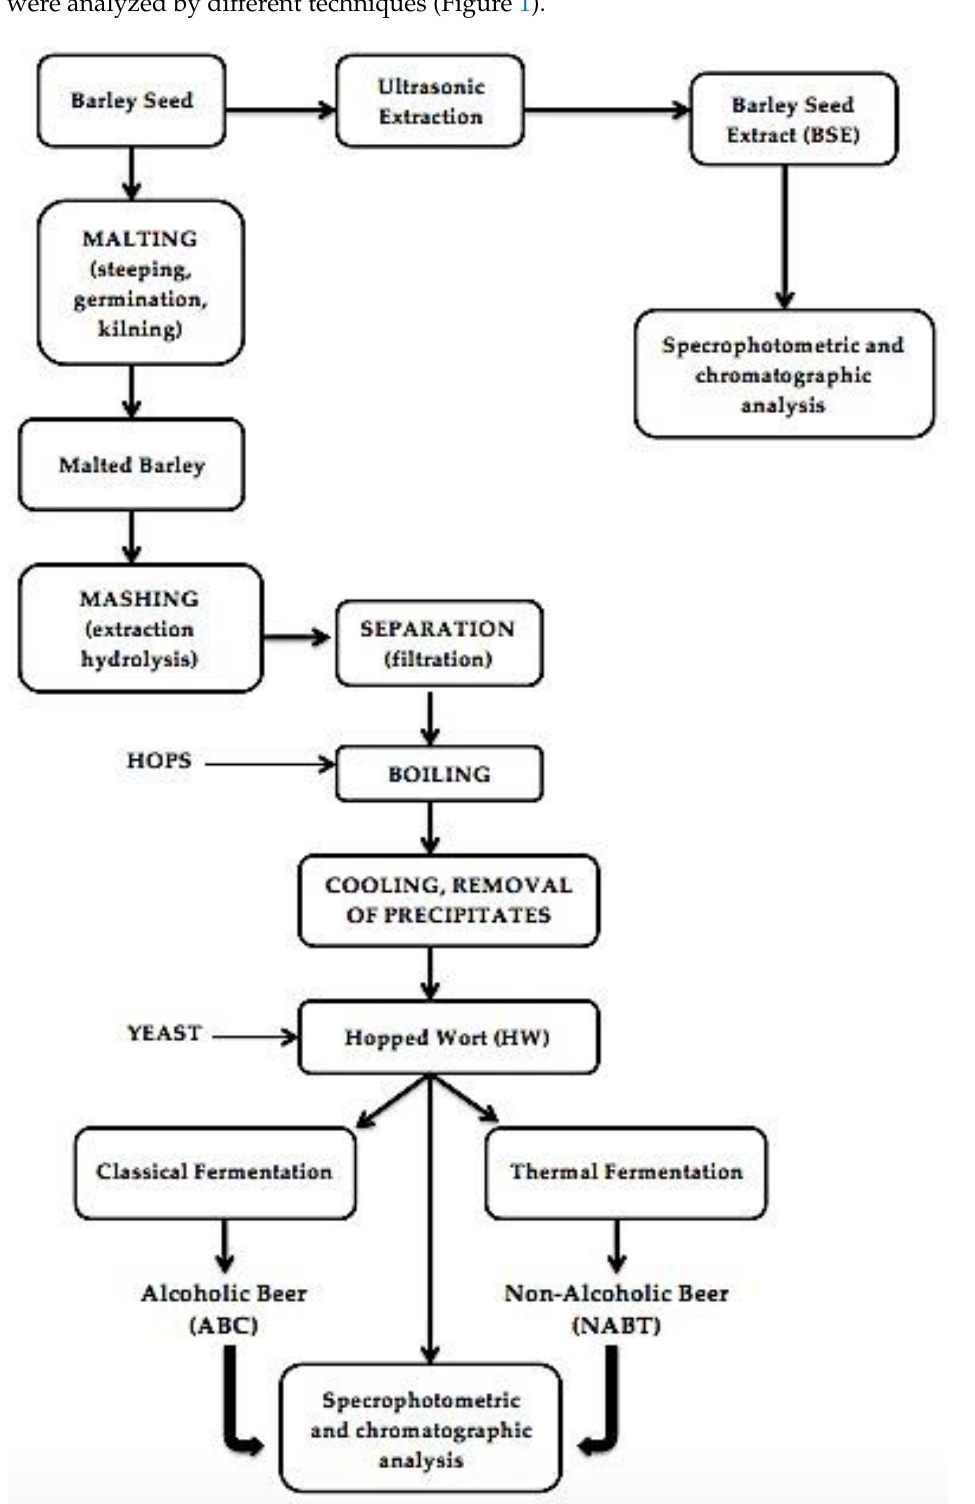
Figure 1. Simplified flowchart of the procedure for the preparation of samples for analysis, during different production processes .